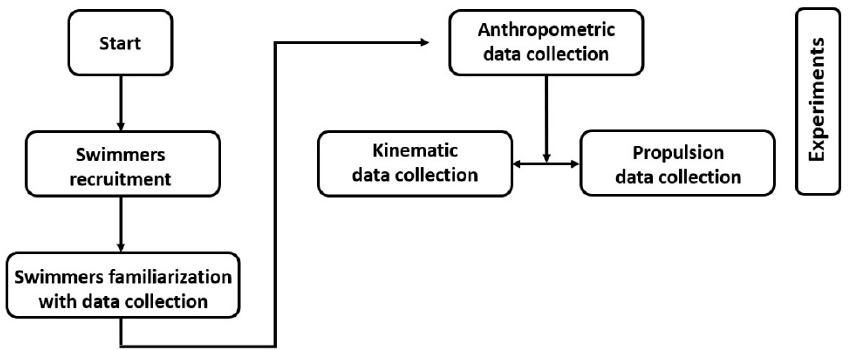
Figure 1. Flowchart of the experimental